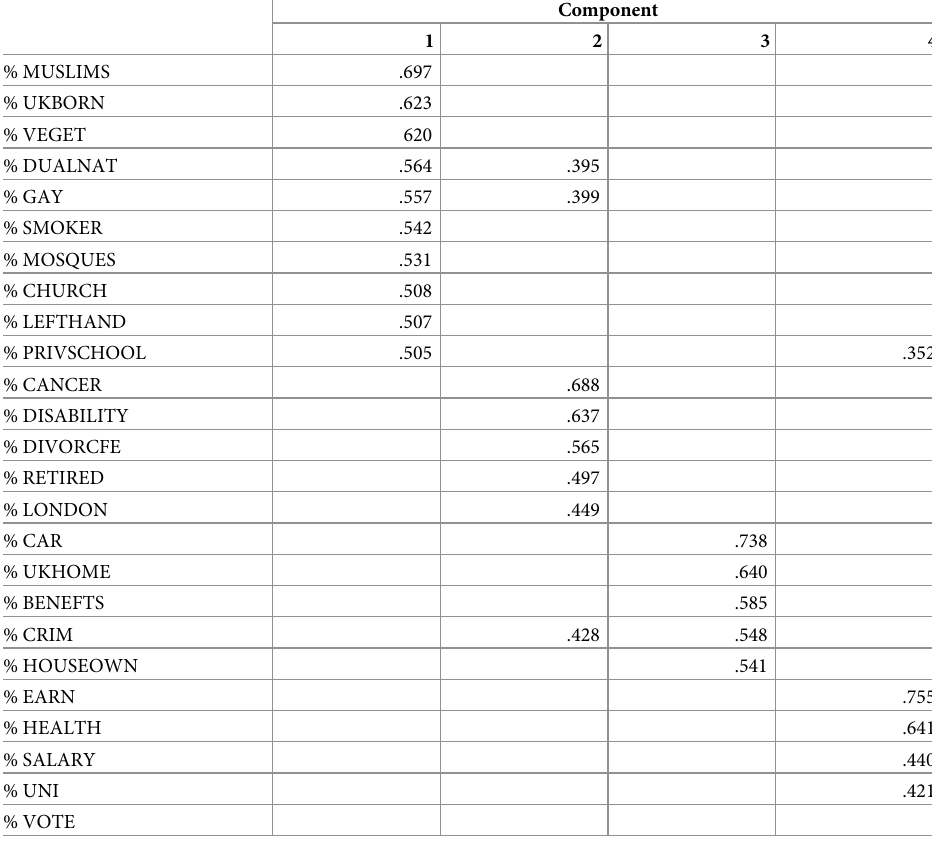
Table 4. Rotated component matrix of the 25 item